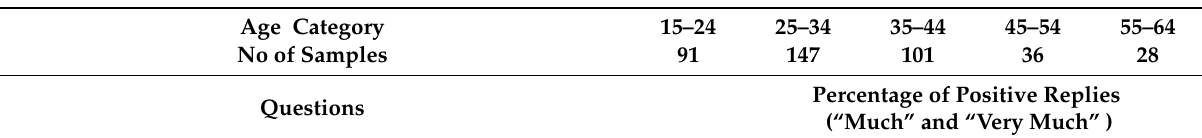
Table 5. Percentage of positive (“Much” and “Very Much”) replies of the Likert Questions according to the age category of the participants.